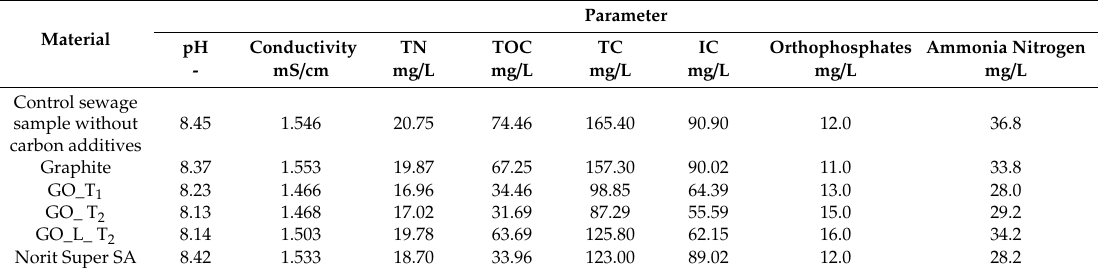
Table 3. Results of wastewater physicochemical analysis after 24 h reaction with selected carbon materials (dose 0.5 g /